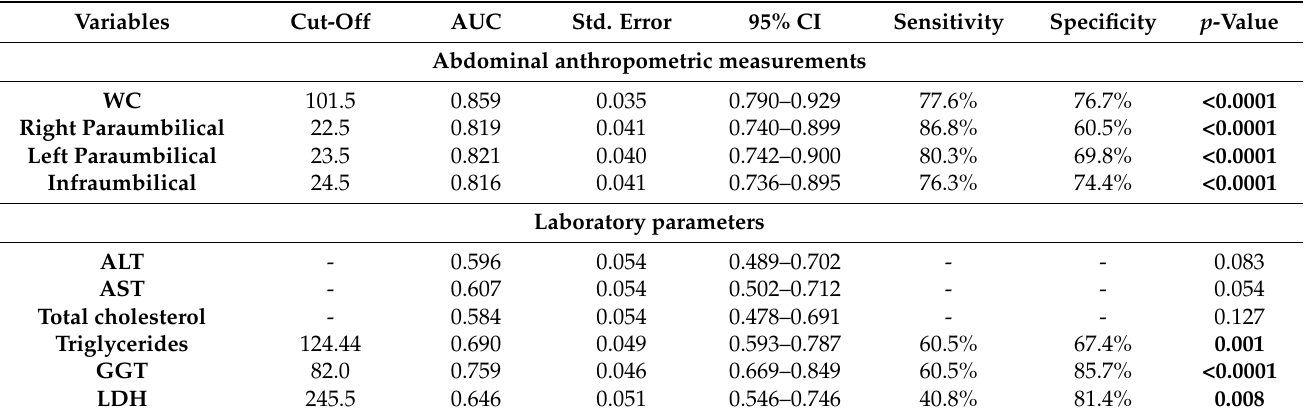
Table 2. ROC curves, ideal cut-off value, AUC, and prediction accuracy of abdominal anthropometric measurements and laboratory parameters and risk of NAFLD.